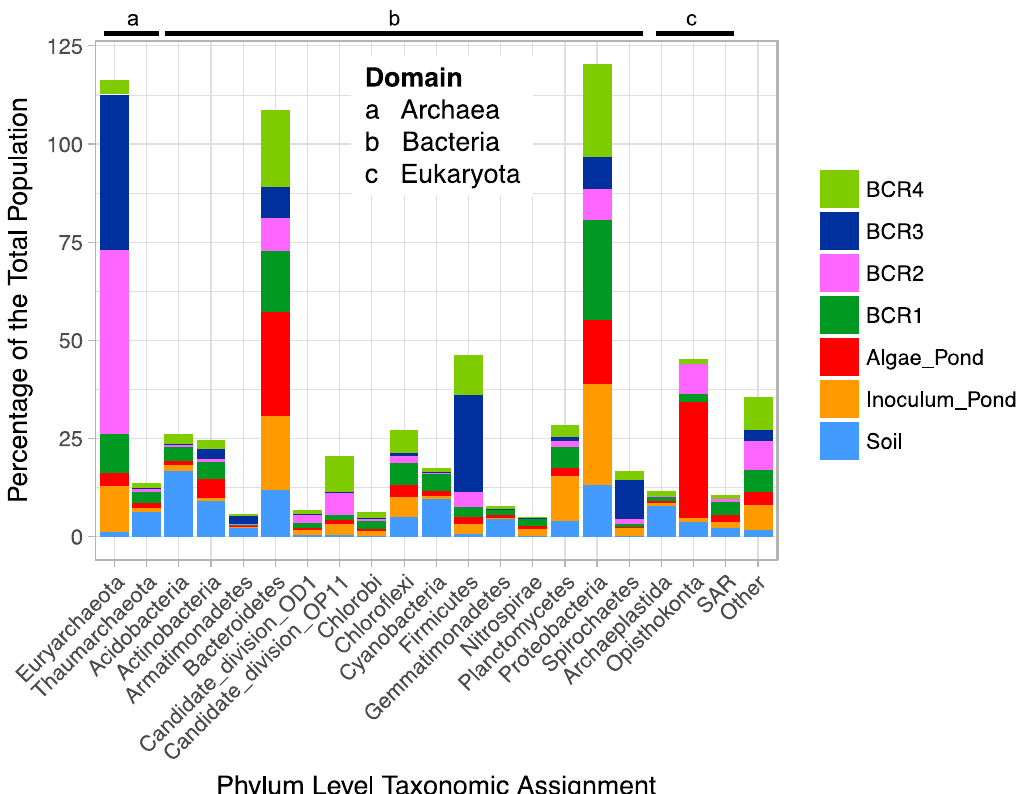
Figure 1. Stacked bar plot of the percentage relative abundance of dominant Phlya in the microbial populations of the BCRs, algae pond, inoculum pond, and soil.